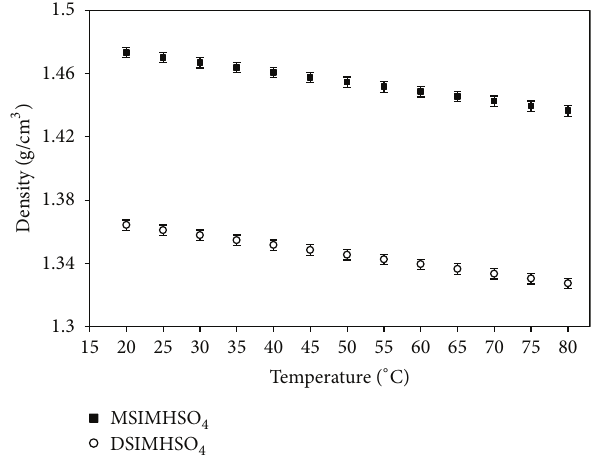
Figure 6: Effect of temperature on density of DSIMHSO 4 and MSIMHSO 4 .